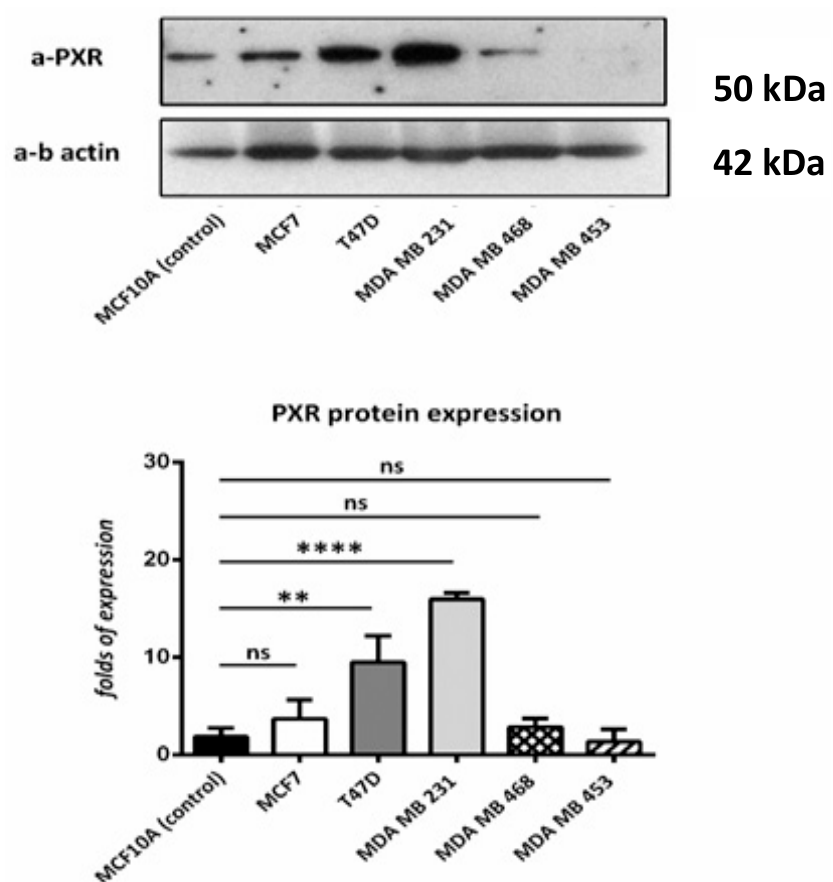
Figure 3. Western blot for PXR. We used MCF10A (as control) T47D, MCF7, MDA-MB-453, MDA-MB-468, and MDA-MB-231 cell lines. PXR is expressed in all the cell lines, despite the different molecular profile. Relative protein amounts were evaluated by a densitometry analysis using ImageJ software. We used three independent samples for each group and β -actin for the normalization. ns: no significant **: p < 0.01 **** p < 0.0001